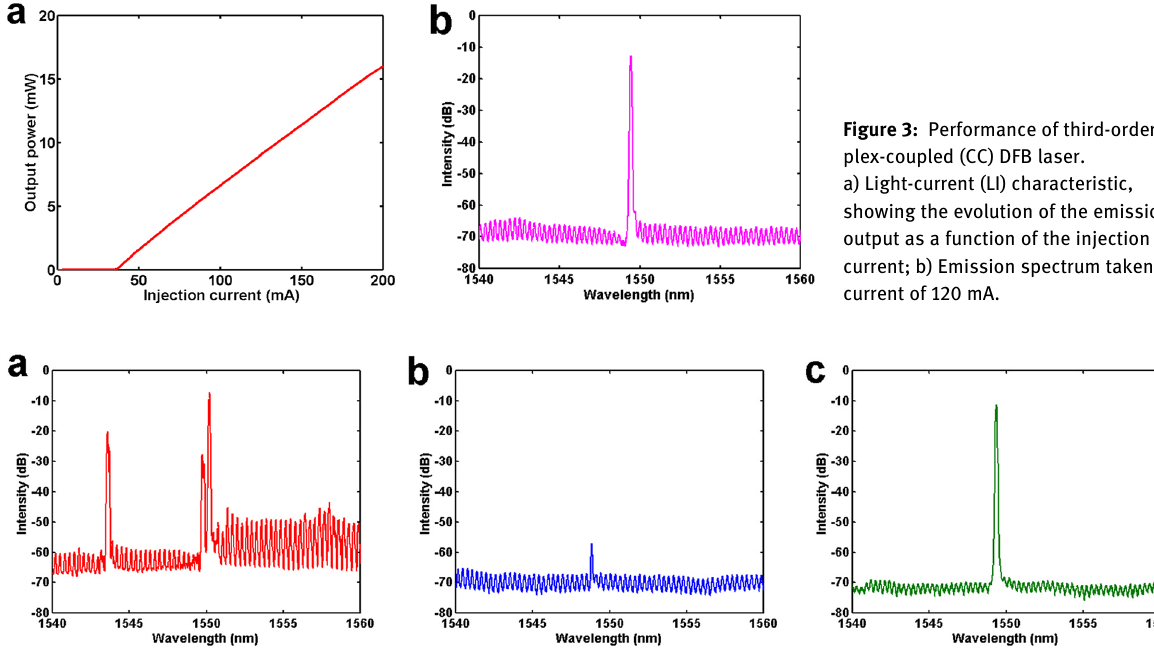
Figure4: Emissionspectraat120mAofa)index-coupled(IC)DistributedFeedbacklaserdiodes(DFB)laserwiththird-orderdielectricgrating; b) gain-coupled (GC) DFB laser with third-order metallic grating; c) GC DFB laser with fi rst-order metallic